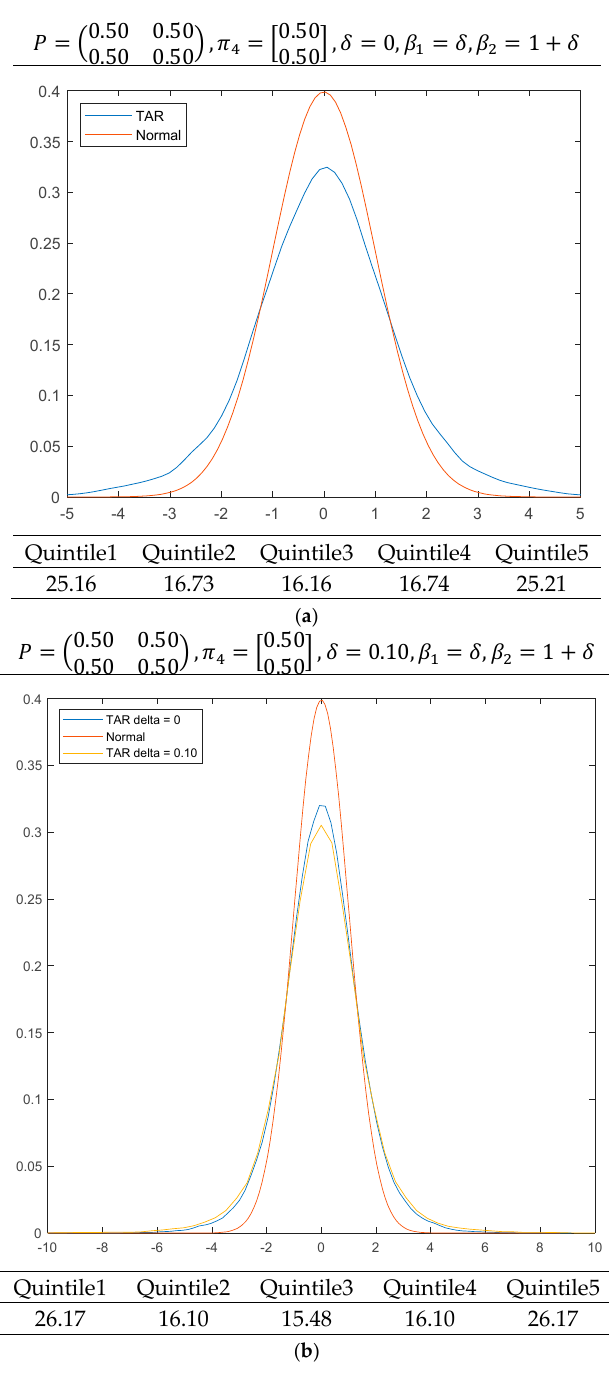
Figure 6. ( a ) Simulated Distributions for TAR(1) with 𝜋 (cid:2872) as the steady state vector and 𝛿 = 0 . ( b ) Simulated Distributions for TAR(1) with 𝜋 (cid:2872) as the steady state vector and 𝛿 = 0.10 .